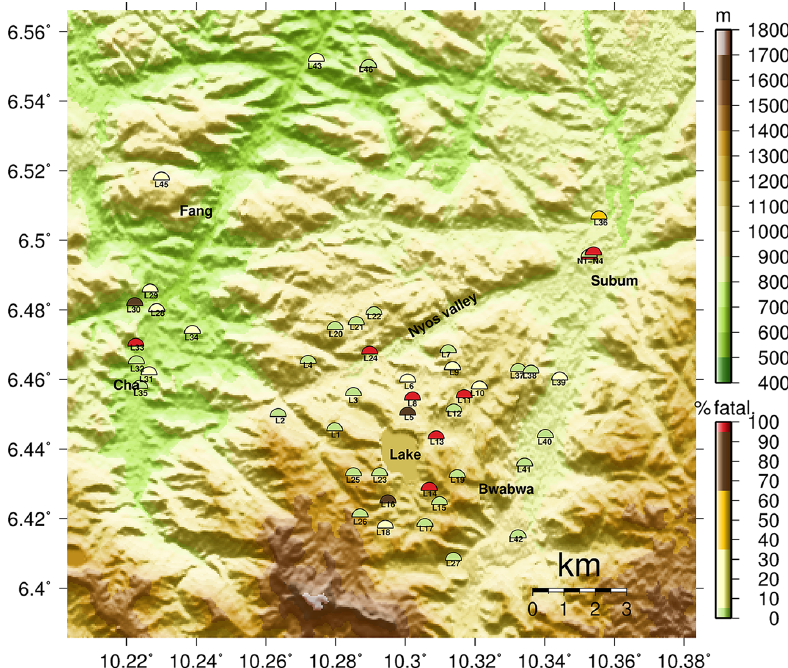
Figure 3. Topographic map of the area around Lake Nyos showing elevation contours (in ma.s.l.). The locations listed in Table 1 are shown by halved circles coloured according the percentage of fatalities (in %) reported by Le Guern et al. (1992).